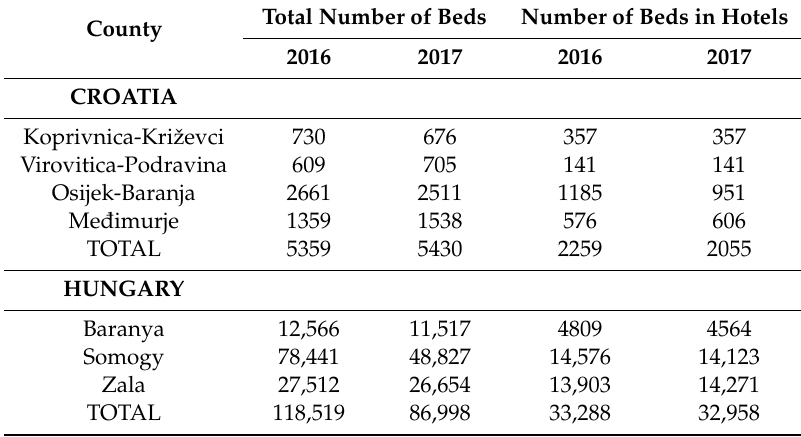
Table 2. Total number of beds and number of beds in hotels in cross-border area, 2016–2017.